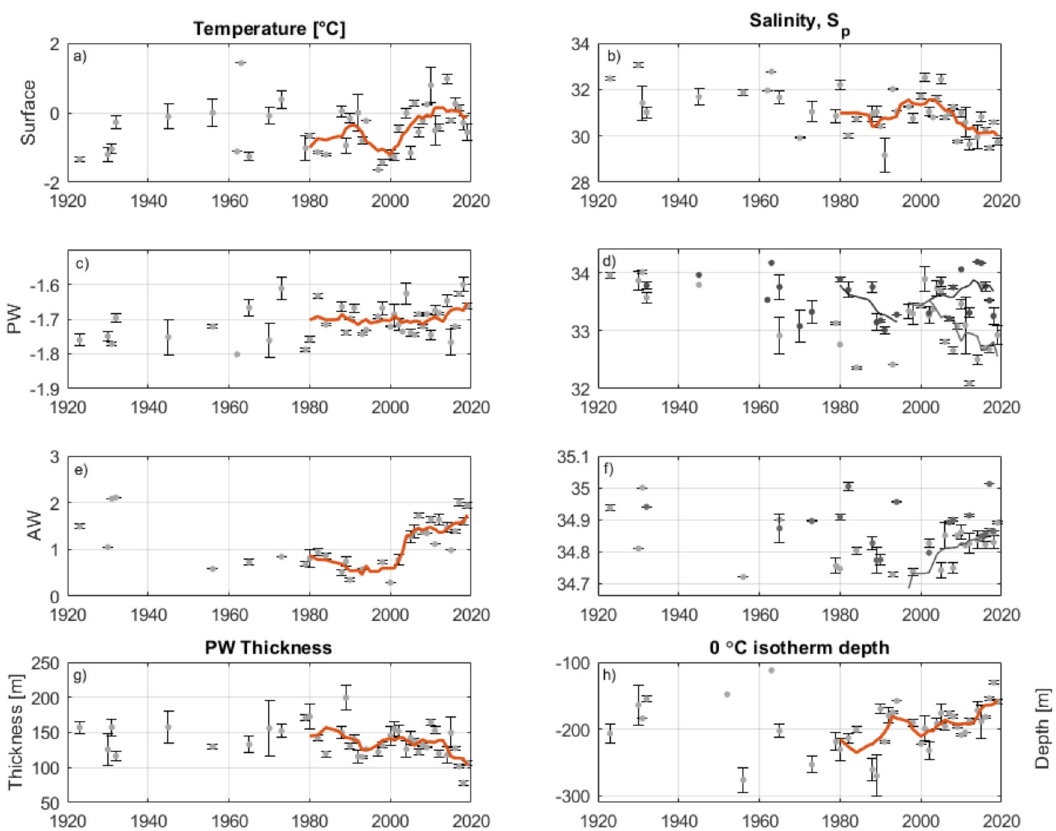
Fig.4|Timeseriesofsummer(July/August/September)shelfwaterproperties. Surface water temperature ( a ) and salinity ( b ) de fi ned as the mean of the 0 – 20 m depth interval, Polar Water (PW) core temperature ( c ), salinity ( d ), and layer thickness ( g ). Atlantic Water (AW) core temperature ( e ), salinity ( f ), and depth of theupperboundaryofAW( h ).In( d )PWand( f )AWcoresalinityispresentednorth